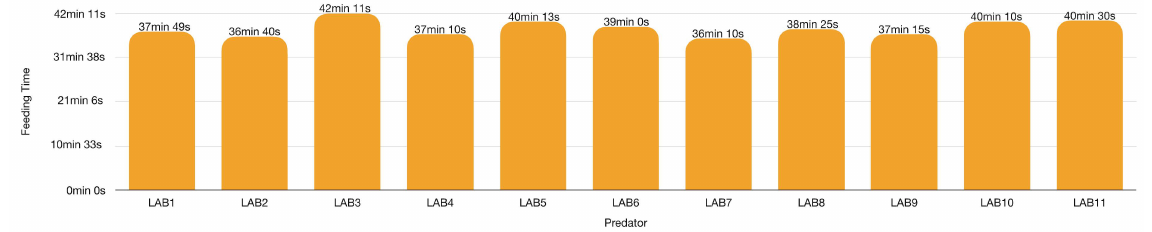
Figure 16. Zelus renardii feeding time per prey in minutes recorded in 580 cm 3 arena per each of the 11 predators, details in Table S4. Each bar represents the average feeding time per 10–12 prey